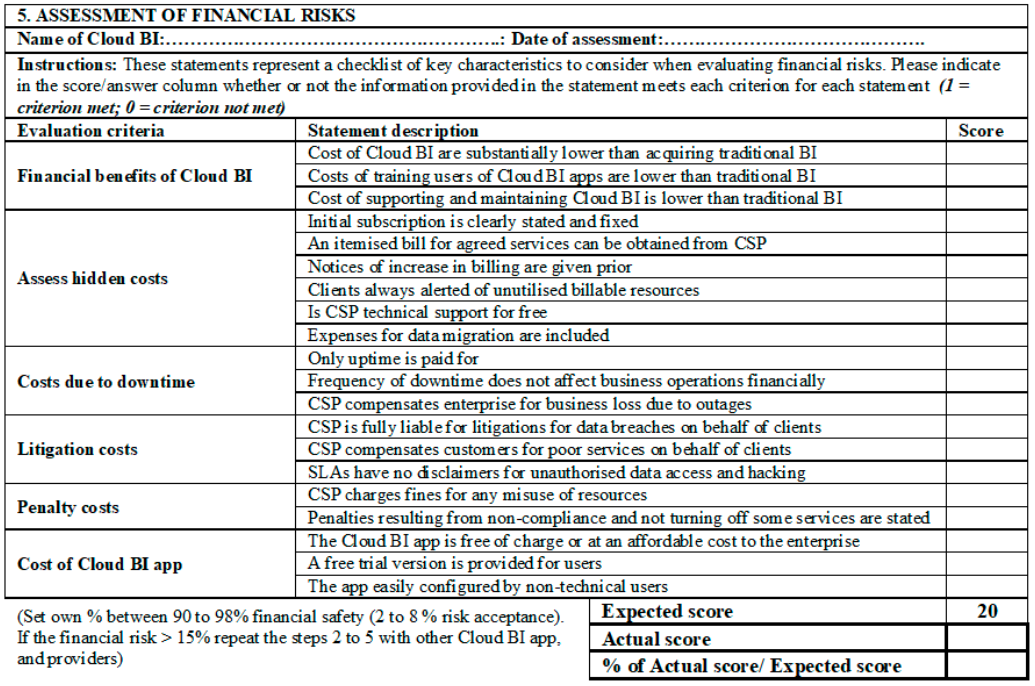
Figure 12. Checklist for assessing financial risks associated with Cloud BI applications.